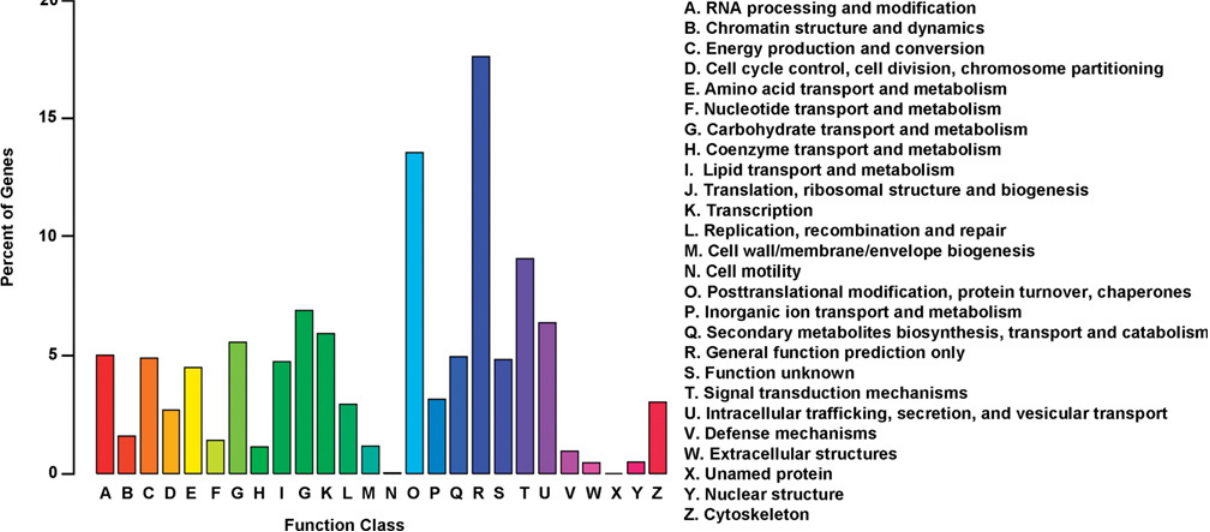
Fig 5. KOG function classification of the transcriptome of the A . sparsifolia primary roots. Out of 24,639 NR hits and 16,417 PFAM homologies, 9,313 sequences have a KOG classification among the 26